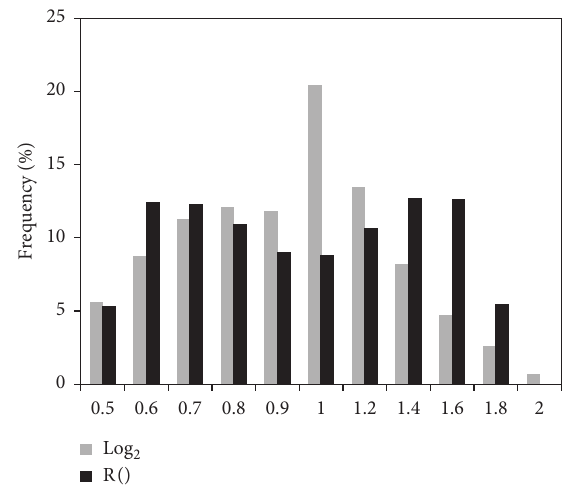
Figure 1: Forecast frequency distribution (%) of the resampled samples using either function R ( · ) or function Log 2 . The l min , l mid , and l max are 0.5, 1.0, and 2.0, respectively. The sample size is 50000, and the initial samples followed the Gaussian distribution with a zero mean and an STD of 1.0. For function Log 2 , the initial samples within ± 1 were